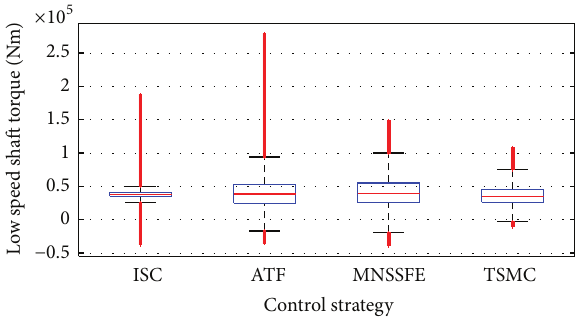
Figure 9: Box plot for low speed shaft torque using FAST simulator.